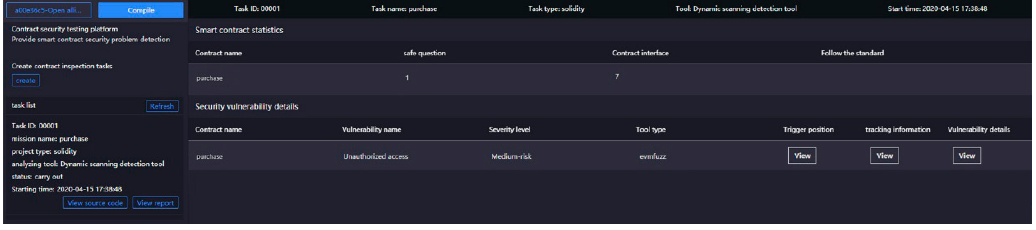
Figure 13. Test results of trade smart contract.